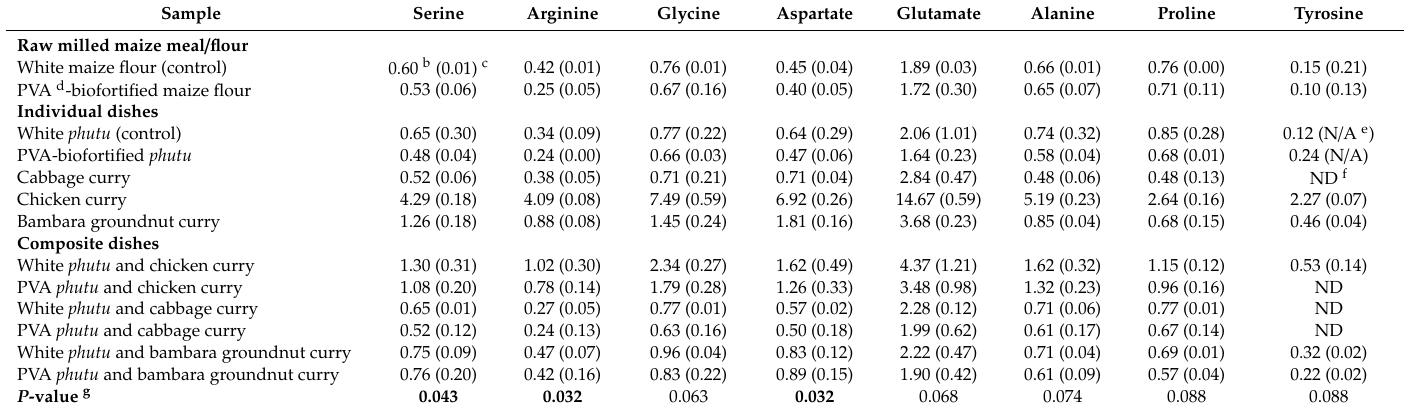
Table 4. Non-essential amino acid composition of uncooked and cooked samples except for sweet potato (g / 100 g, DW a ). Sample